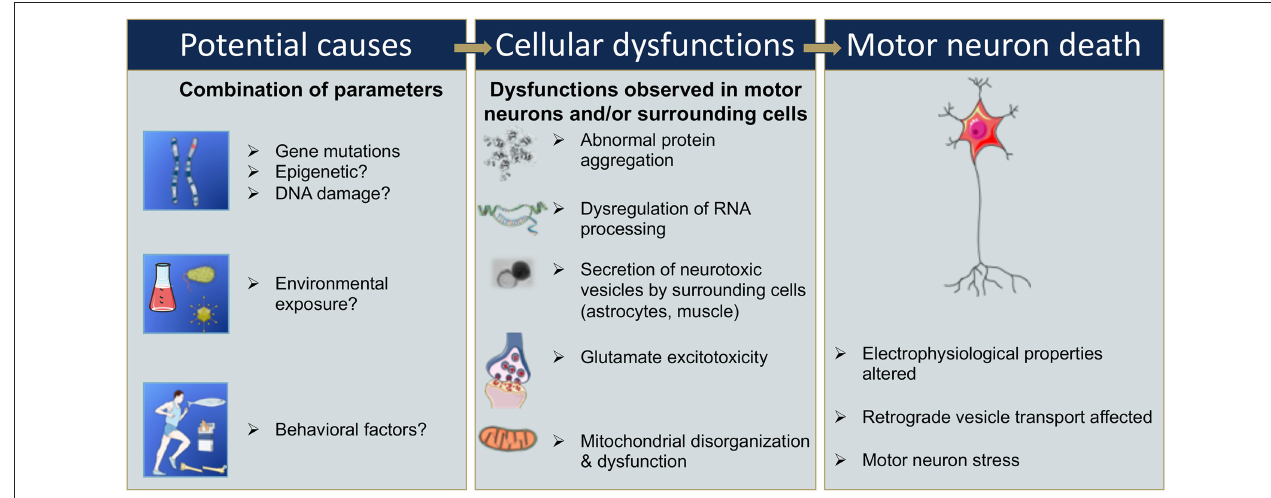
FIGURE 2 | Sequential events that could be involved in motor neuron death in ALS. Gene mutations, epigenetic changes, or DNA damage that occur either spontaneously or due to environmental risk factors such as exposure to toxins or infectious agents, or behavioral factors, have all been proposed as potentially leading to cellular dysfunction ( 9, 13, 14, 20–23). Cellular dysfunction could include abnormal protein aggregations, alteration of RNA processing, secretion of neurotoxic vesicles by surrounding cells such as astrocyte, muscle cells, glutamate excitotoxicity, and mitochondrial disorganization and dysfunction leading to oxidative stress ( 24–30). These cellular dysfunctions may take place in motor neurons and/or surrounding cells and, combined or alone, could lead to an alteration of the electrophysiological properties of the motor neuron, and/or to an induction of secretion of neurotoxic elements by surrounding cells, in either case ultimately leading to motor neuron death (